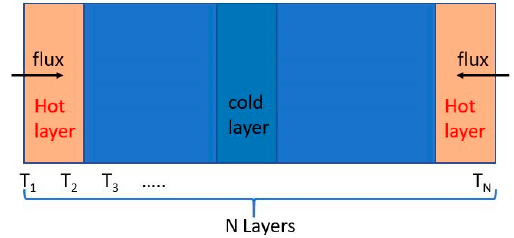
Figure 4. Schematic diagram of the heat transfer settings.